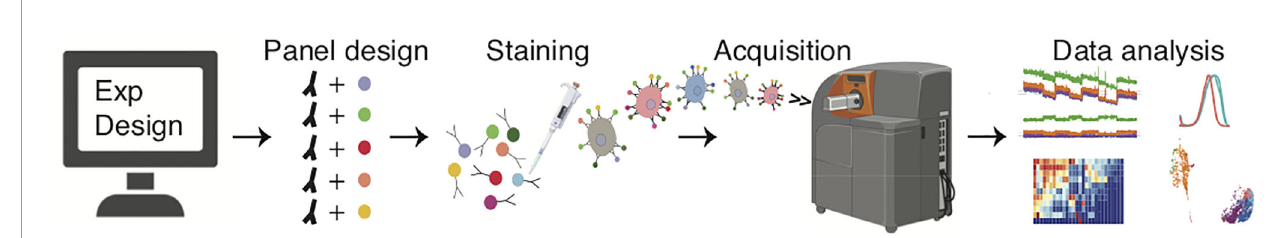
FIGURE 1 | Typical work fl ow used in mass cytometry experiments. An experiment starts with careful design of an antibody/probe panel. This is followed by sample processing, staining and acquisition, and fi nally data